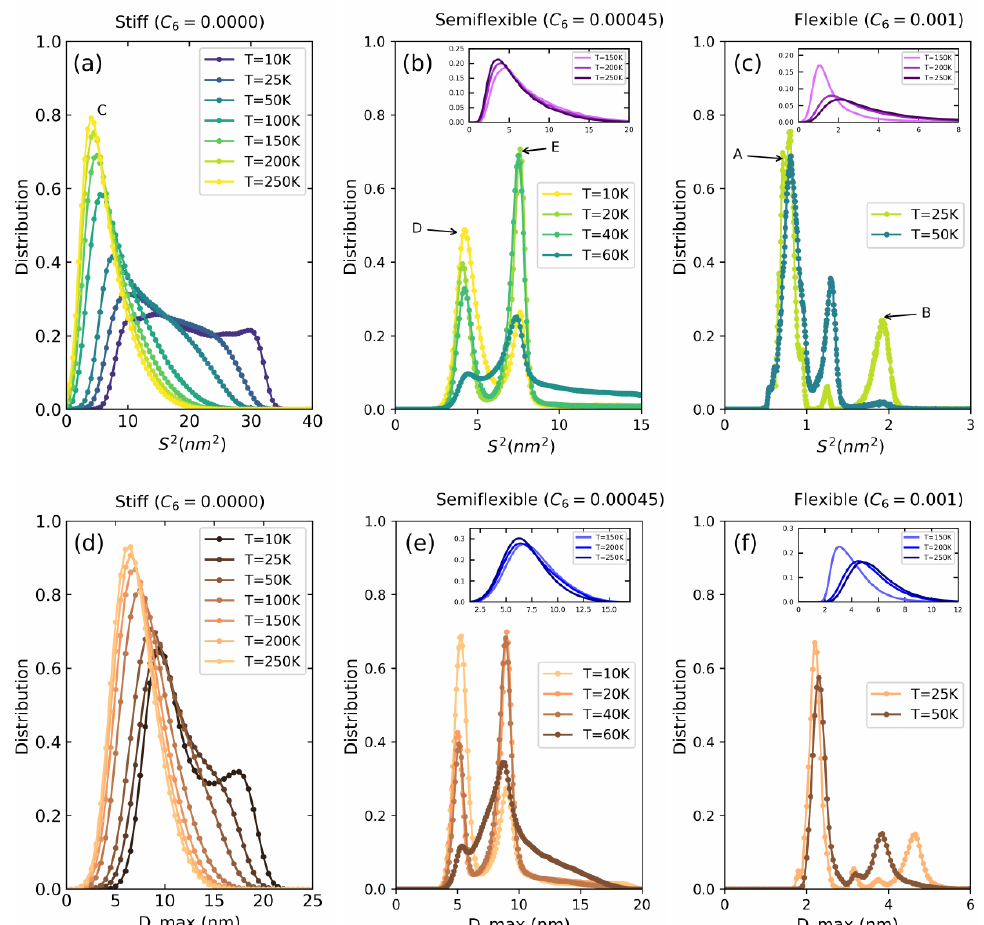
Figure 3. Distribution of S 2 for ( a ) stiff ( C 6 = 0.0000), ( b ) semiflexible( C 6 = 0.00045), and ( c ) flexible ( C 6 = 0.001) polymers. Distribution of D max ( d ) stiff ( C 6 = 0.0000), ( e ) semiflexible ( C 6 = 0.00045), and ( f ) flexible ( C 6 = 0.001)